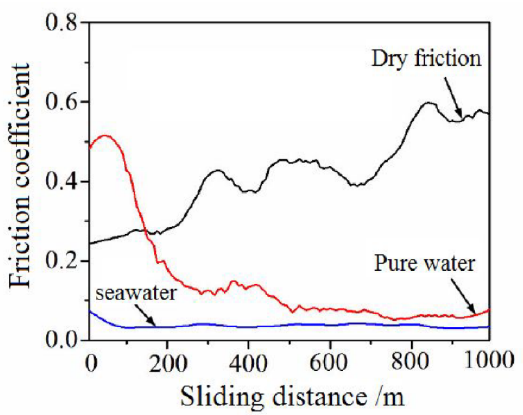
Figure 3. Friction coefficients of the SN10/GCr15 tribopair under the different conditions.